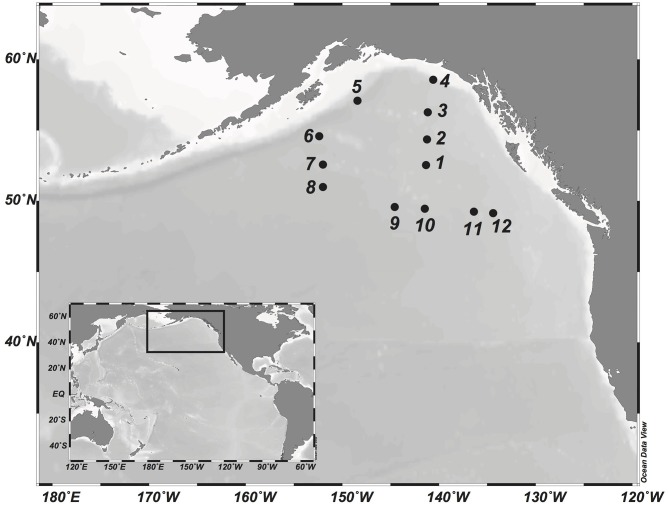
Map of the study area in the Gulf of Alaska. Sampling sites occupied during the DORC research cruise in 2013 are indicated by numbered dots.